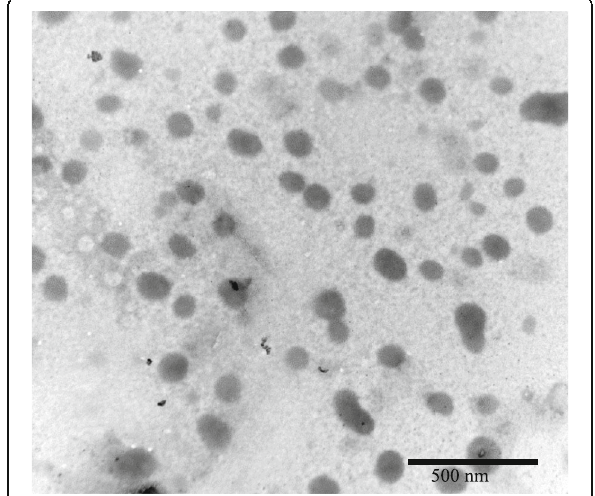
Fig. 4 A TEM image of the nanoparticles synthesized by Rawal et al. These nanoparticles have a size distribution of 20 – 100 nm